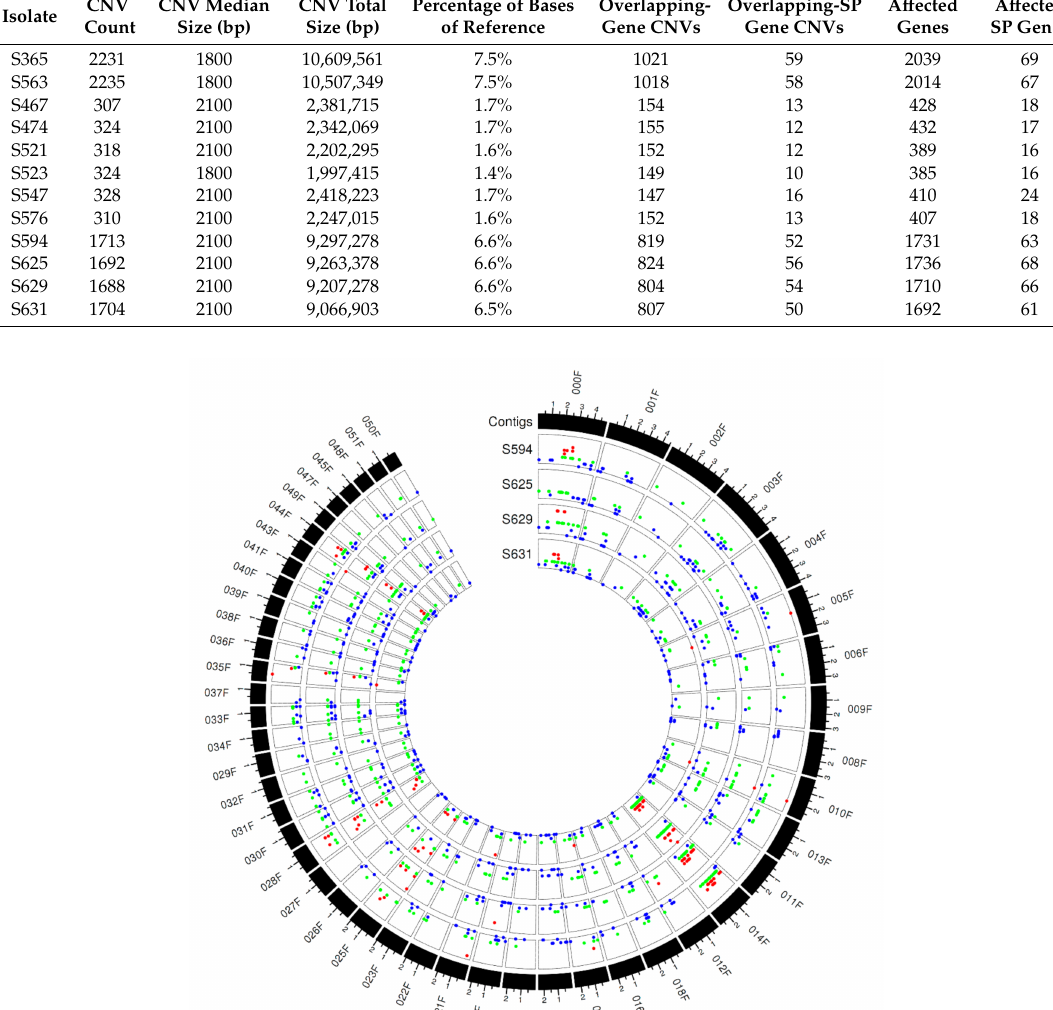
Figure 3. Genomic landscape of detected CNVs (copy number variations) for Pt isolates S594, S625, S629, and S631, which comprised the four isolates used to identify candidates for AvrLr1 . Tracks from outside to inside are: (1) contigs and (2)–(5) CNV locations for S594, S625, S629, and S631. The height of each point represents the related copy number value. Red / green / blue, respectively, indicates the copy number is greater than, equal to, and less than 2. Each major tick on the contig track is for 1 Mb